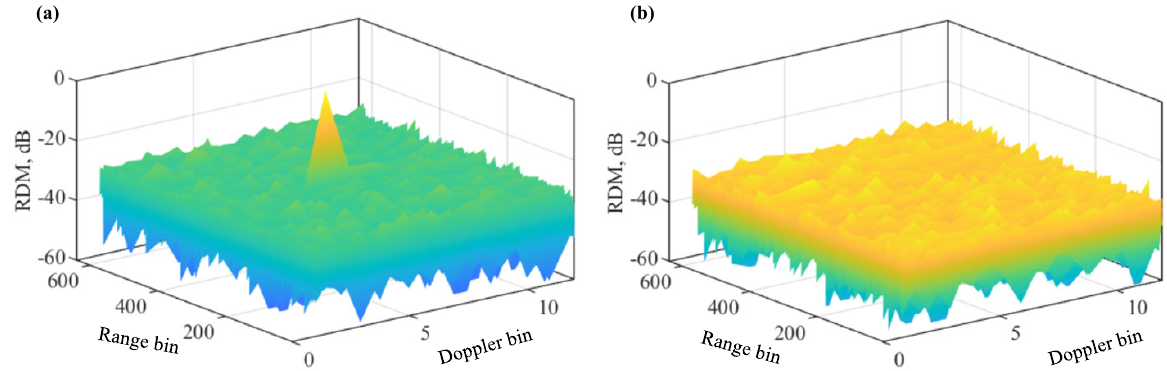
Figure 4. RDM of Algorithm 3 in ( a ); RDM of Algorithm 4 in ( b ). A single target is set here. Please note that the symbol “-” before all numbers, as automatically generated by MATLAB during plotting the figure, denotes the negative sign.